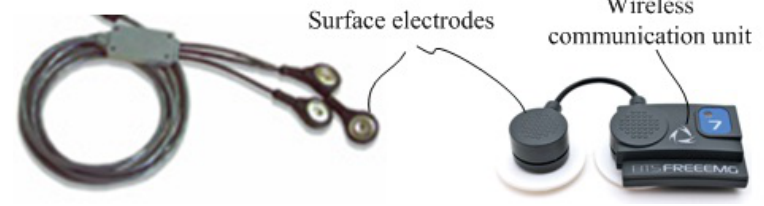
Figure 3. Commercialized wireless EMG sensors. The wireless EMG sensors include the electrodes and wireless communication